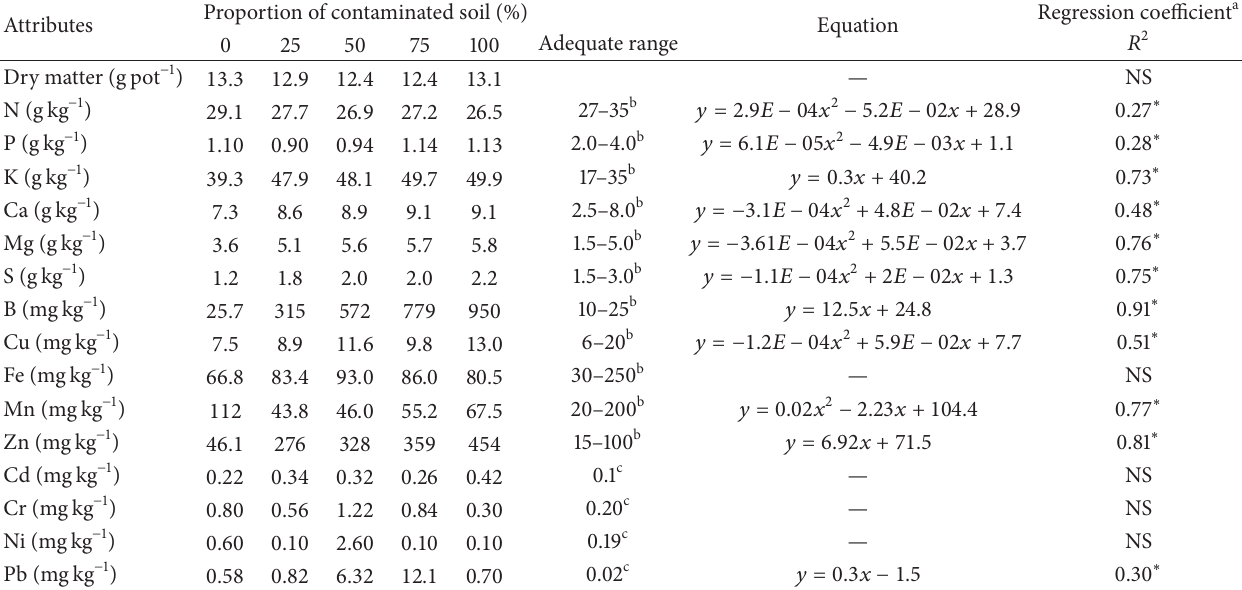
Regression coefficient a Equation 2